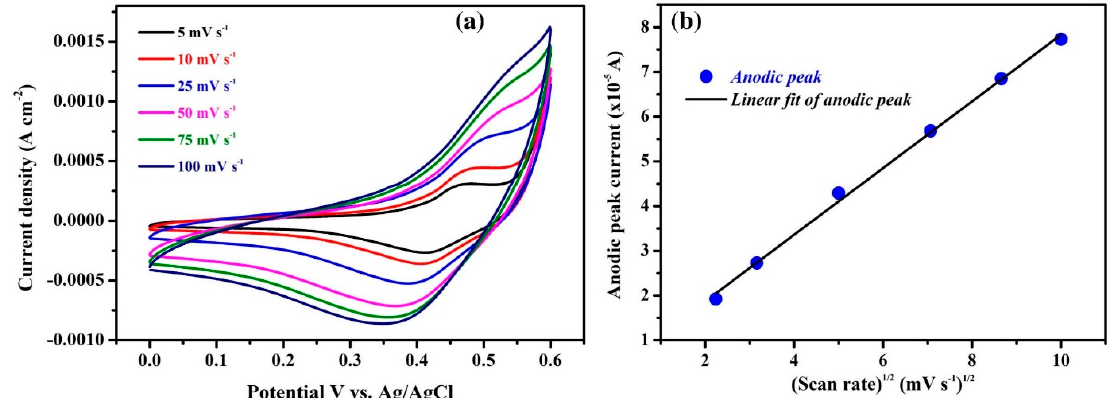
Figure 3. Cyclic voltammetry (CV) curves at different scan rates ( a ) and anodic peak current vs. the square root of the corresponding scan rate ( b ) for sheet-like ZnCo 2 O 4 .